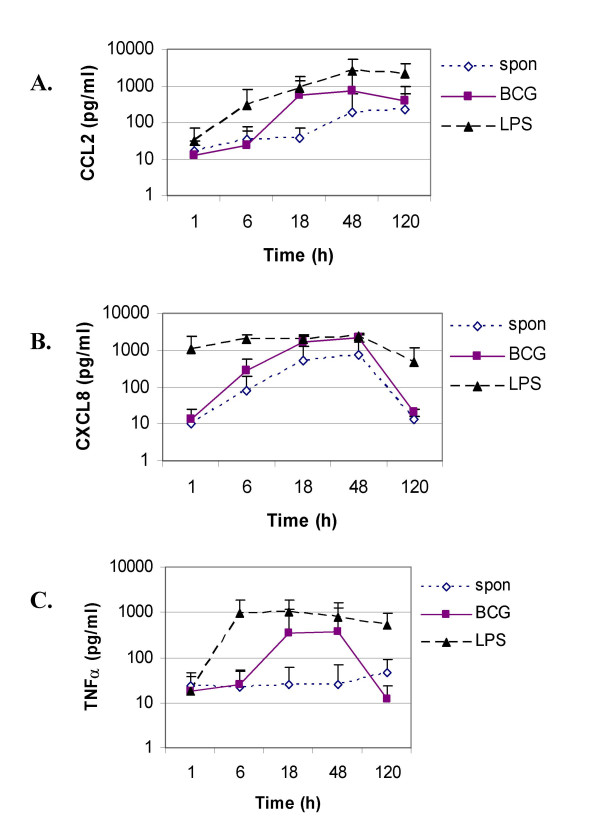
Time-dependent secretion of Mycobacterium-, and LPS- induced CCL2, CXCL8 and TNFα. Whole blood cells (106) from healthy controls (N = 12) were stimulated with M. bovis BCG (2 × 105 CFU/ml, ratio of 0.2 bacilli per cell) and LPS at 0.1 μg/ml. Supernatants were harvested at 1, 6, 18, 48 and 120 h post-stimulation and tested for cytokine activity. Mean values are illustrated with SD indicated as 'y' error bars. A. CCL2, B. CXCL8, C. TNFα. Un-stimulated cells (spon) '◇', BCG stimulated '■' and LPS stimulated '▲'.